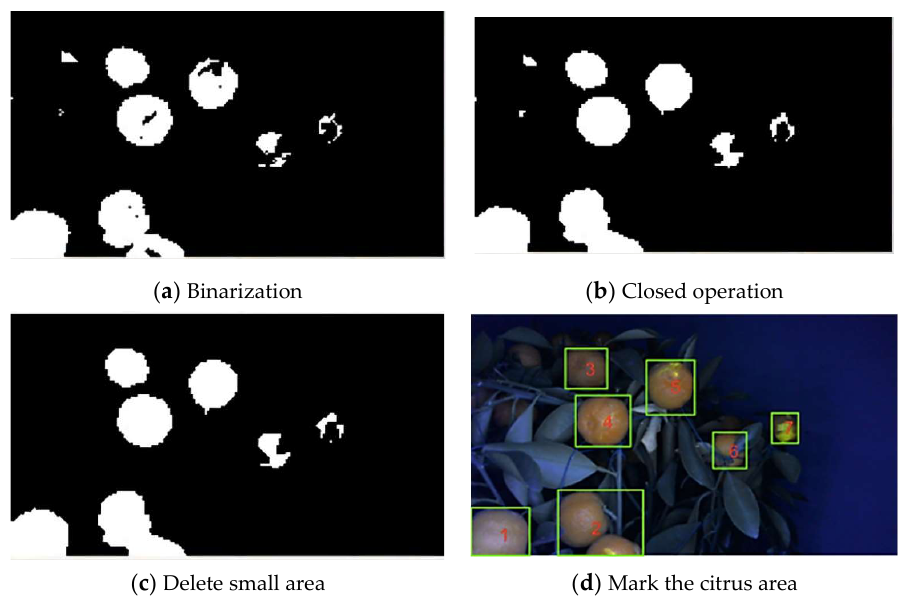
Figure 12. Processing and labeling of citrus areas. The numbers in the box in Figure ( d ) show the corresponding citrus area.